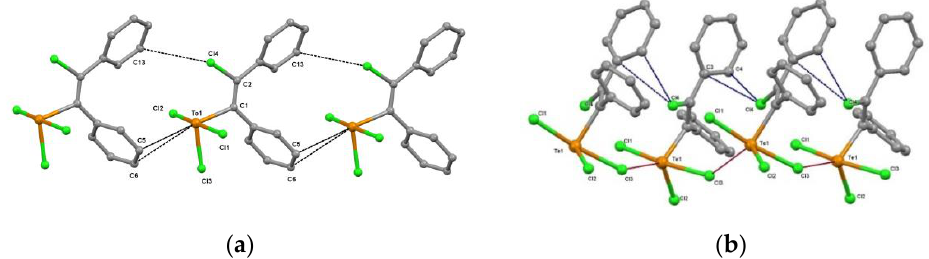
Figure 1. Packing pattern of Z- Cl(Ph)C=C(Ph)TeCl 3 molecules in the polymorphic forms 1α ( Pca 2 1 , refcode BESHOW [14] ) ( a ) and 1β (Cc) ( b ). Hydrogen atoms are omitted for clarity. Selected intra-